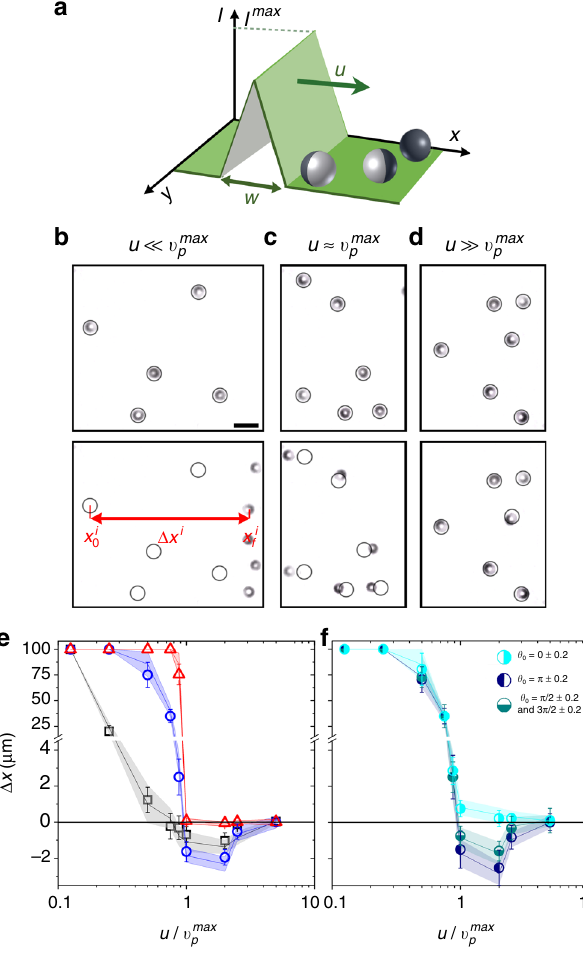
right with different velocities. At low pulse speeds u (cid:3) v max APs are displaced to the right, at u (cid:4) v max